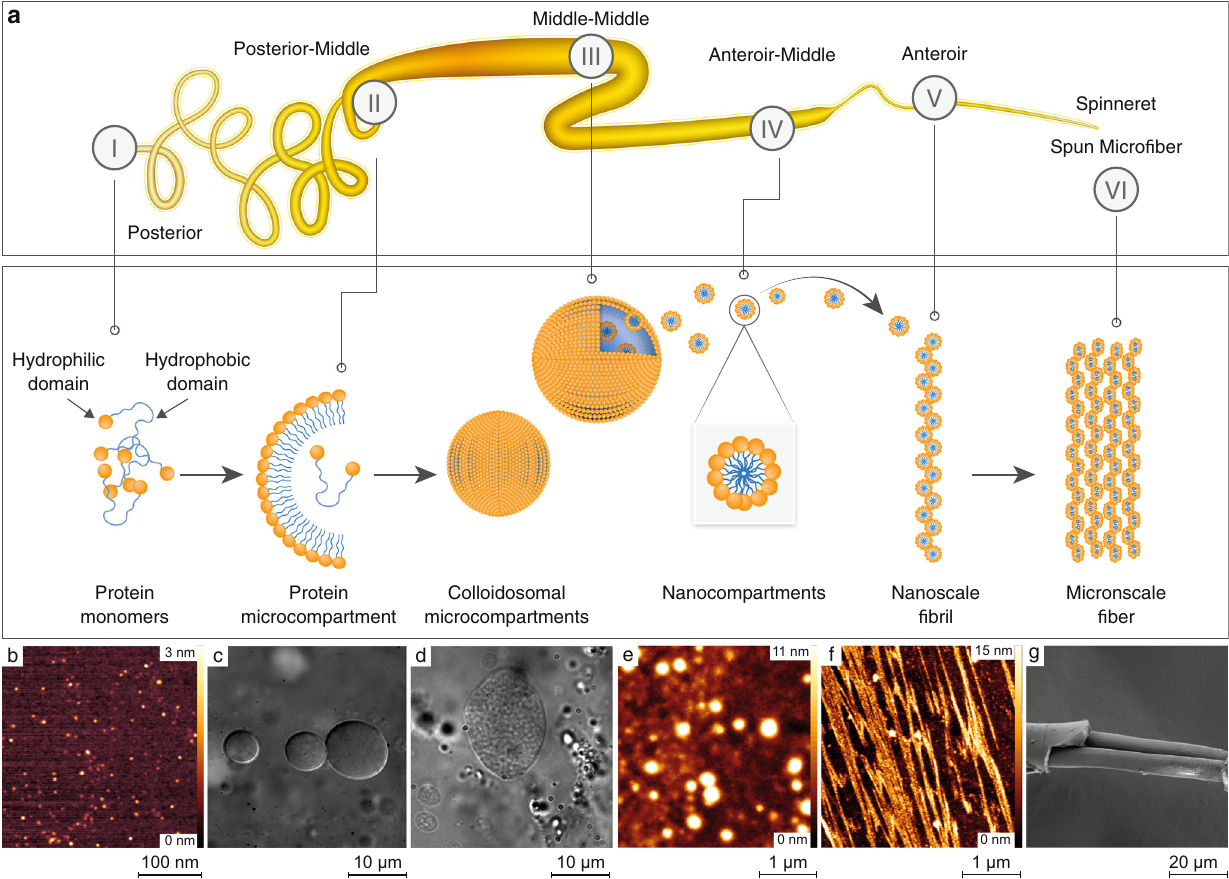
Fig. 1 | Mechanism underlying silk transformation from soluble protein into solid nano fi laments. a Schematic representation of the fi ve regions of the silk- worm silk gland (top panel) and their corresponding silk protein supramolecular phases (bottom panel): (i) posterior region, where protein monomers are synthe- sized, (ii) posterior-middle region, where protein microcompartments were detected, (iii) middle-middle, where appearance of colloidosomal microcompart- ments was observed, (iv) anterior-middle, where the presence of